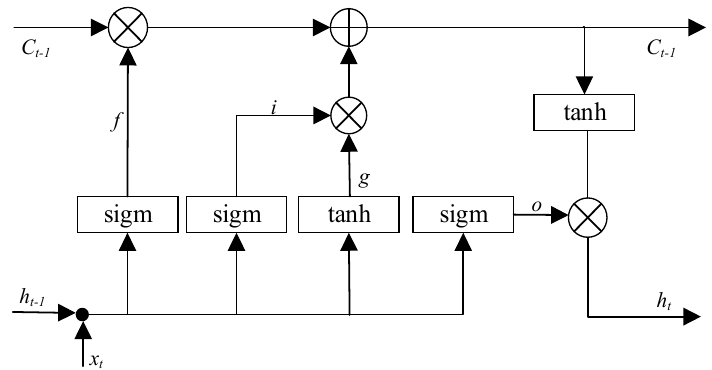
Figure 3. Structure of the LSTM neural network.